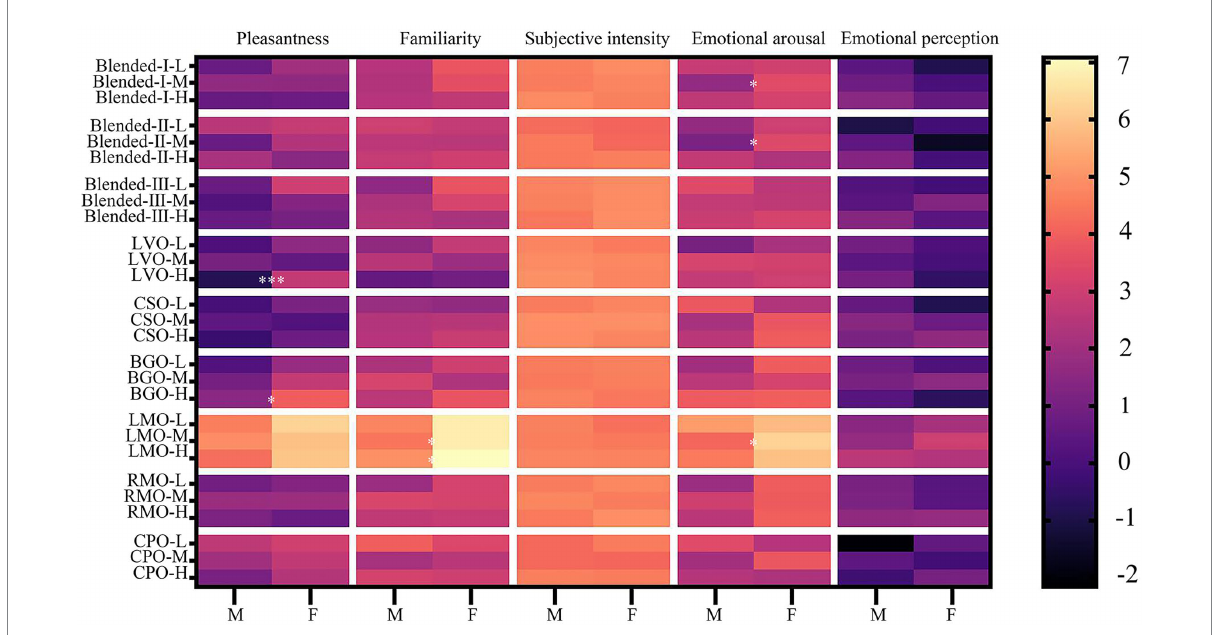
FIGURE 3 Sensory evaluation of odor between male and female. Mean ratings ( n = 25) on pleasantness, familiarity, subjective intensity, emotional arousal, and emotional perception at low (L), mid-range (M), and high (H) concentrations between male and female. M: male, F: female. The asterisk indicates that the odor evaluation results of the two groups show significant differences. * p < 0.05, ** p < 0.01, *** p < 0.001. Data were analyzed by main effects analysis with two-way mixed ANOVAs, a post hoc Bonferroni test was